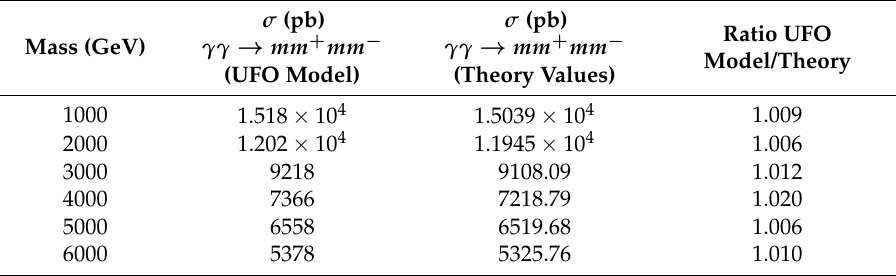
Figure 1. The Feynman Diagram produced by M AD G RAPH for the spin 0 magnetic monopole scenario. Here, “mm+” suggests monopole, “mm-” shows the anti-monopole, and “a” describes the photon. Table 1. The cross-section for the spin 0 monopole as obtained by the theory and the M AD G RAPH UFO model for the β -independent coupling when no PDF is used and the center-of-mass energy is 13 TeV. The fourth column shows the ratio of the cross-sections of the UFO model to that of the theoretical prediction. These ratios are very close to 1, suggesting excellent agreement between the theory and the M AD G RAPH model